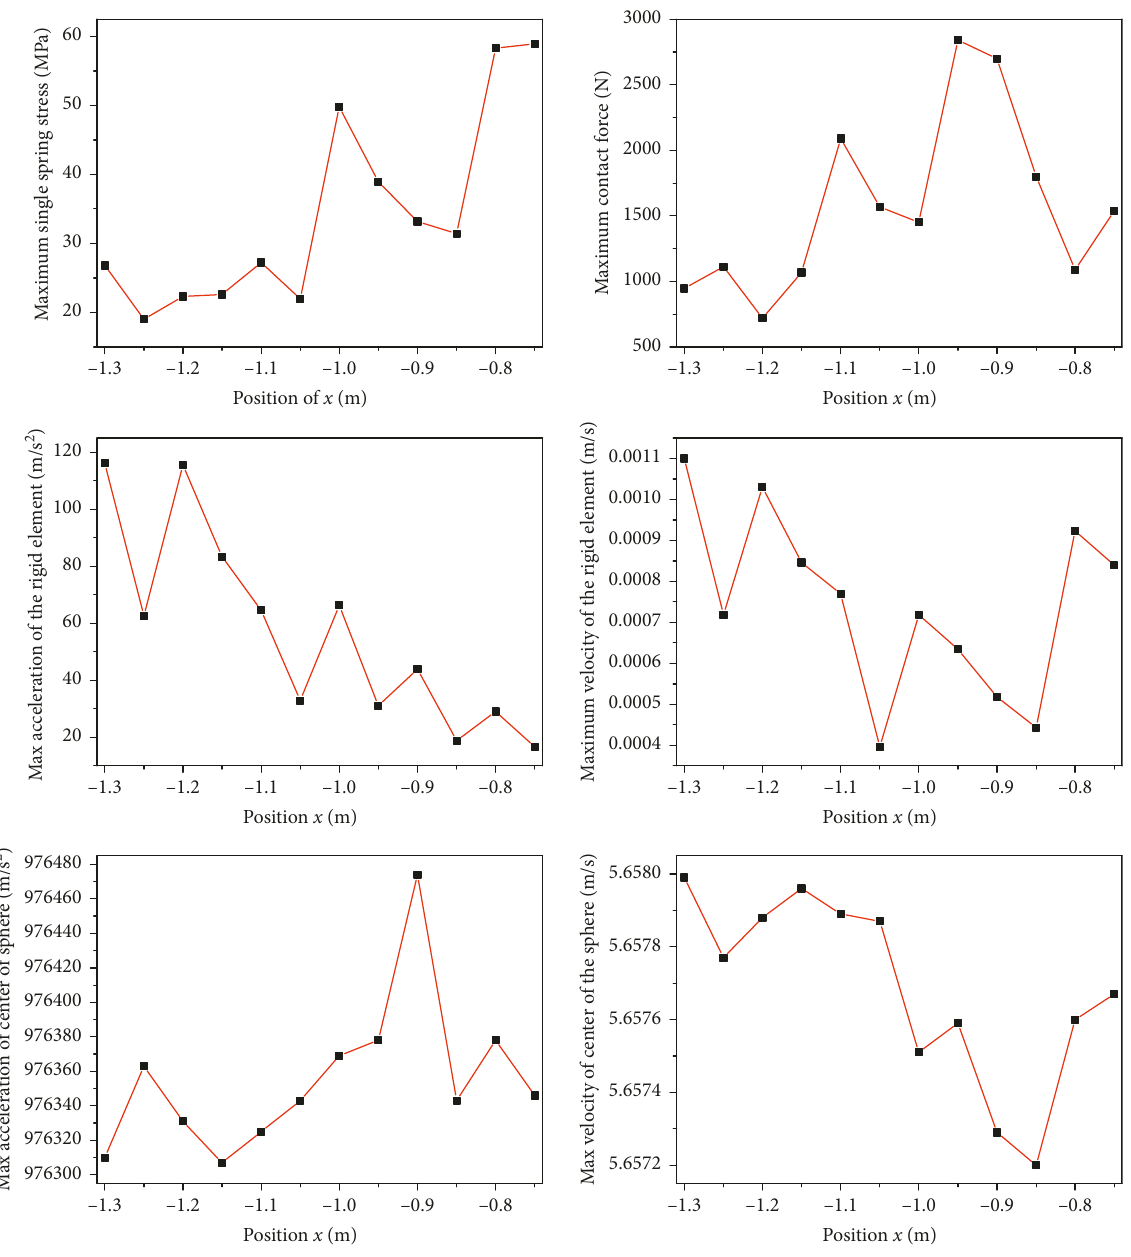
Figure 29: Maximum contact